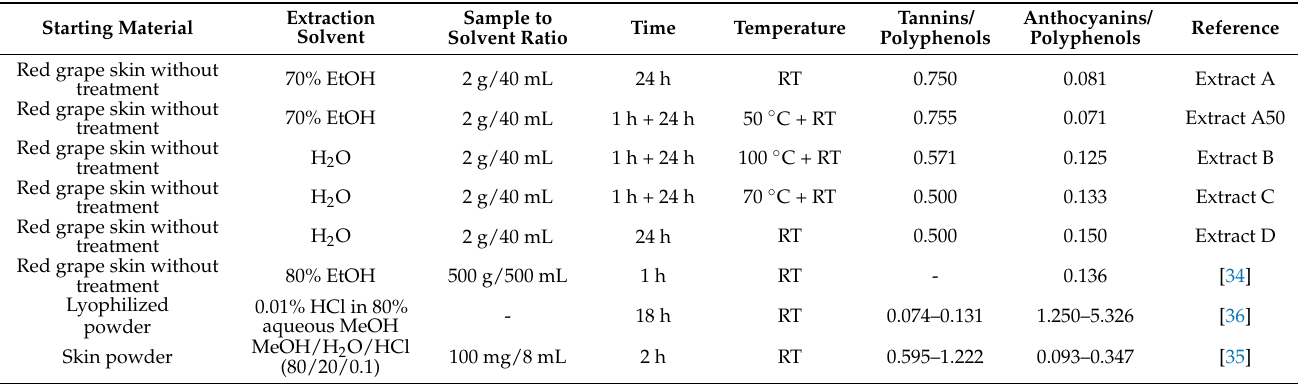
Table 4. Comparison of different SLE of grape skin extracts with relative tannins/polyphenols and antho- cyanins/polyphenols